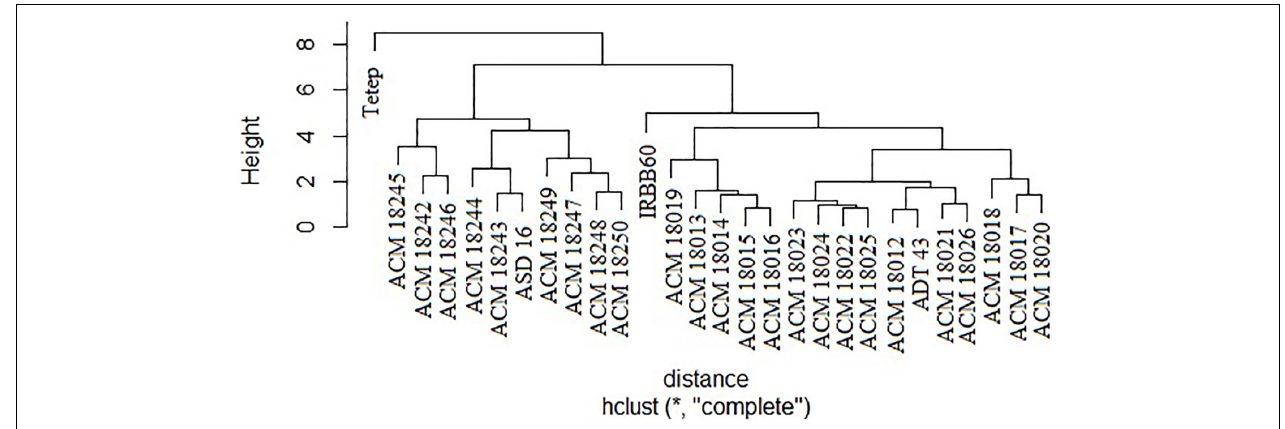
FIGURE 6 | Clustering of 24 selected improved pyramided lines based on 10 morphological characters. *Euclidean